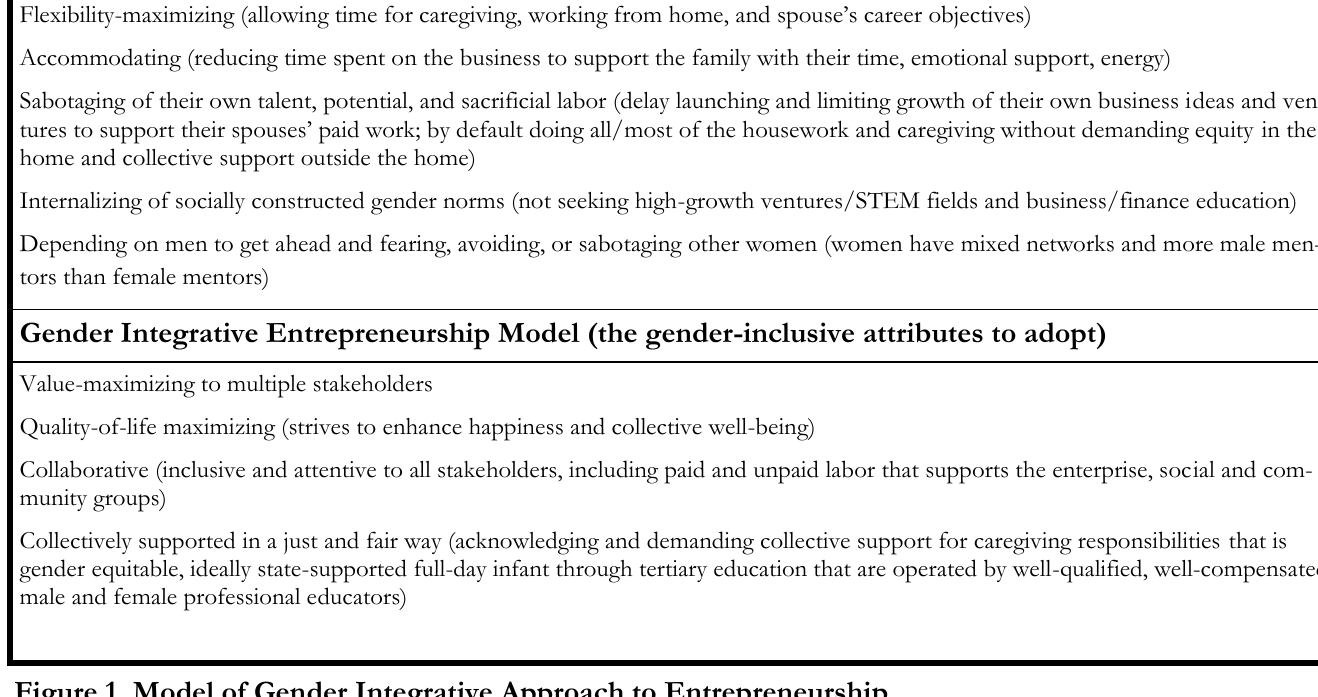
Figure 1. Model of Gender Integrative Approach to